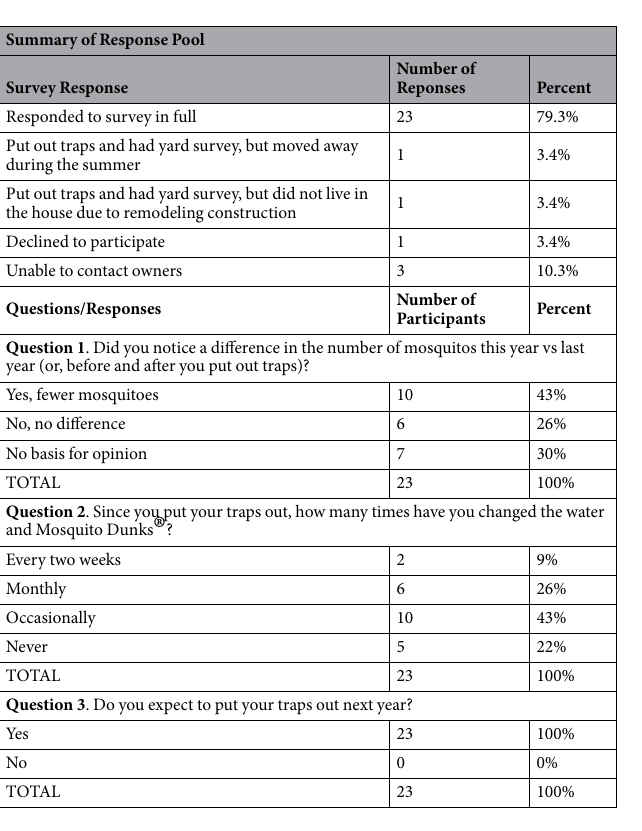
Table 2. Description and summary of block survey. A total of 29 residents within a single block were contacted and surveyed by their block captain. Of the 29 residents, 23 completed the full